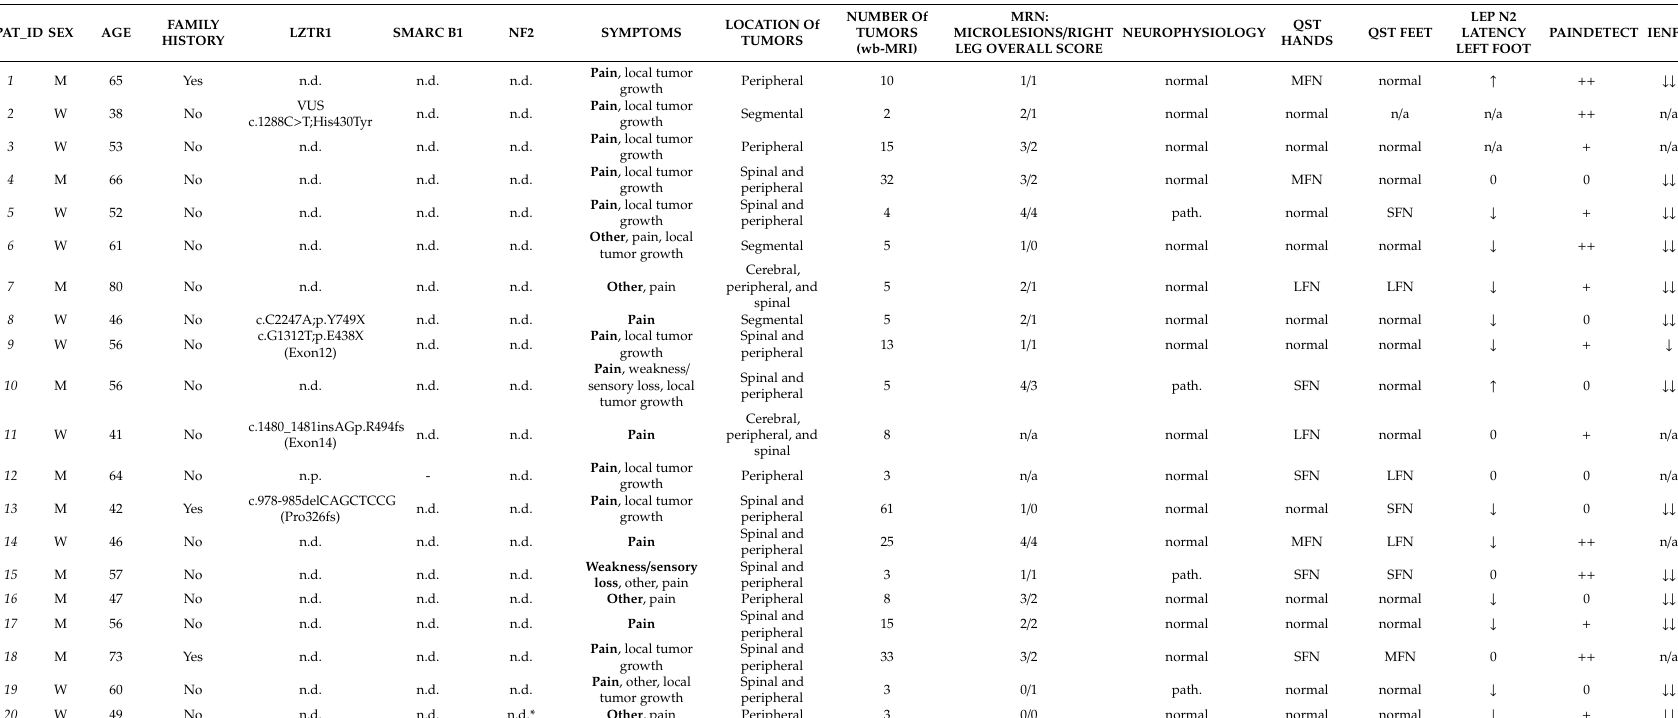
Table 1. Baseline characteristics of all included patients. Sex, age at examination, family history, germline mutations in LZTR1 , SMARCB1 , or NF2 genes: Sanger sequencing using blood-derived DNA; rearrangements involving the NF2 gene were not detected by MLPA (* if available tumor tissue was investigated for NF2 mutations: patient #20 has two di ff erent NF2 mutations in two schwannomas), symptoms: bold: first symptom, other: non-neurological symptoms, location of tumors, number of schwannomas detected in wbMRI, microlesions (MRN) / MRN right leg overall score: number of microlesions on hr-MRI (MRN) / mi-crolesions (0: none; 1: low lesion load; 2: intermediate lesion load; 3: high lesion load; 4: very high lesion load), neurophysiology (normal or patho-logical), QST: normal, small fiber neuropathy (SFN), mixed fiber neuropathy (MFN), or large fiber neuropathy (LFN), LEP: N2 latency (exemplatory of the left foot), semiquantitative description according to the 95% confidence interval of the normgroup: shorter ( ↓ ), normal (0) or longer ( ↑ ) latency, PainDETECT: 0: no evidence for neuropathic pain, + : inconclusive, ++ : suggestive for neuropathic pain, IENFD: intraepidermal nerve fiber density (IENFD; n / mm) according to age and sex adjusted reference values (0: normal, ↓ : on the 5% reference value; ↓↓ : below the 5% normative); n / a: not